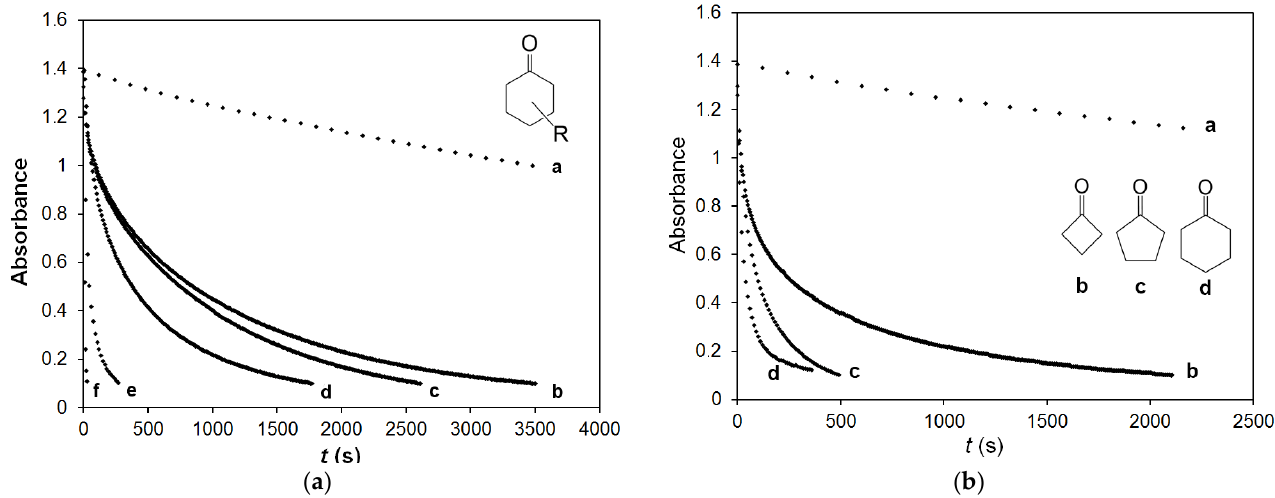
Figure 9. Stoichiometric Baeyer–Villiger oxidation of cycloketone derivatives: ( a ) Absorbance change at 760 nm versus time in the 3 PhIO -mediated oxidation of cyclohexanones: without substrate (a), 4- tert -Butylcyclohexanone (b), 3-Methylcyclohexanone (c), 2-Methylcyclohexanone (d), Cyclohex- anone (e), 4-Methylcyclohexanone (f). Reaction conditions: [ 3 ] = 10 − 3 M, [sub.] = 0.35 M, at 15 °C; ( b ) Absorbance change at 760 nm versus time in the 3 PhIO -mediated oxidation of cycloketones: without substrate (a), cyclobutanone (b), cyclopentanone (c), cyclohexanone (d). Reaction conditions: [ 1 ] = 10 − 3 M, [sub.] = 0.35 M, T = 15 °C, the intermediate was generated with PhIO in MeCN.